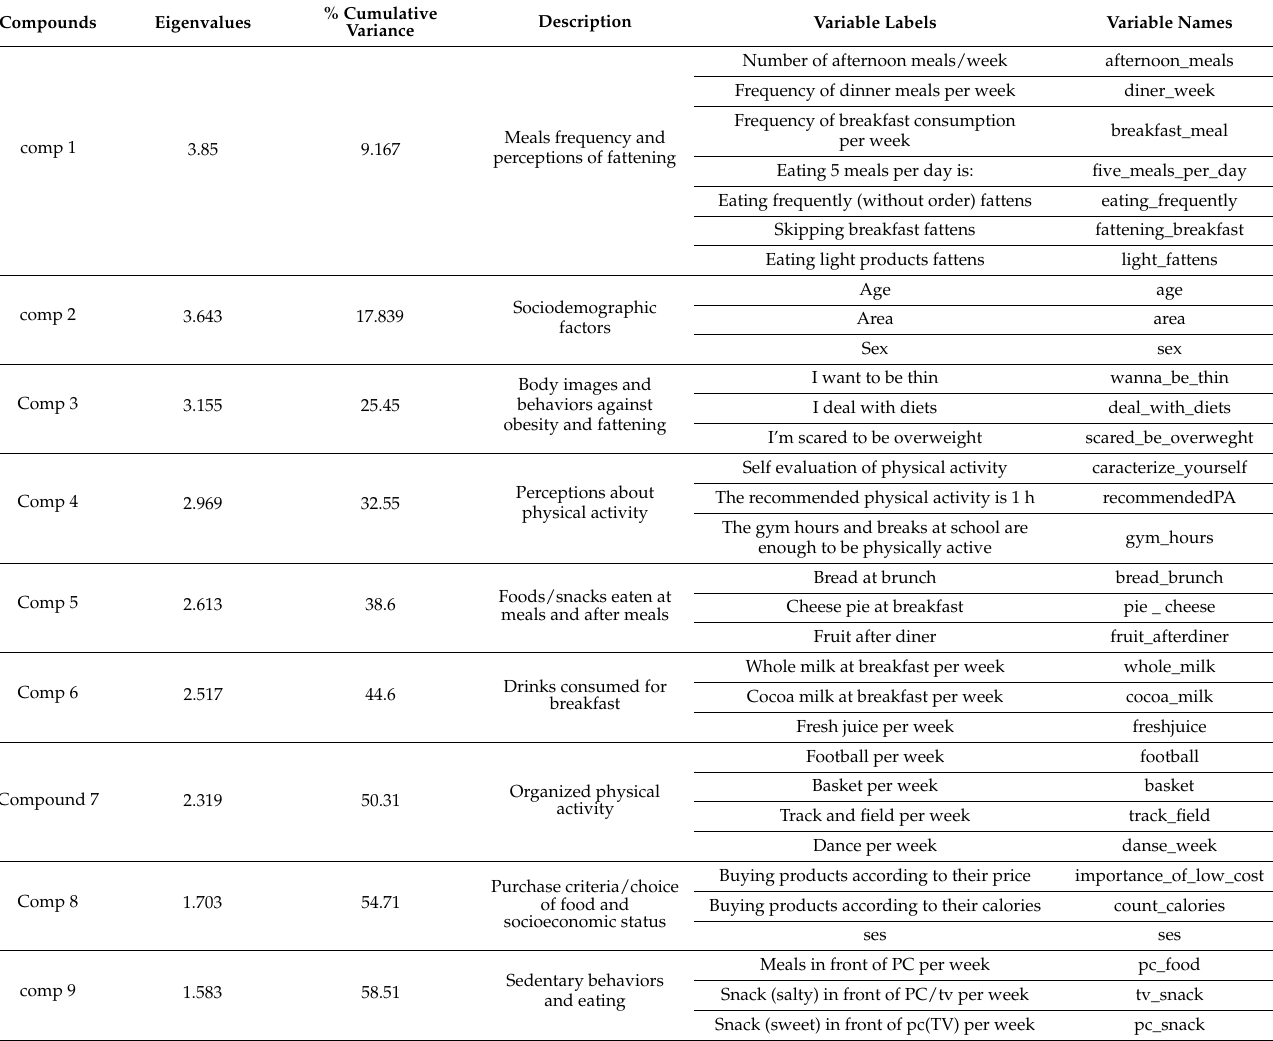
Table A2. Factors extracted by Factor Analysis of Mixed Data and variables